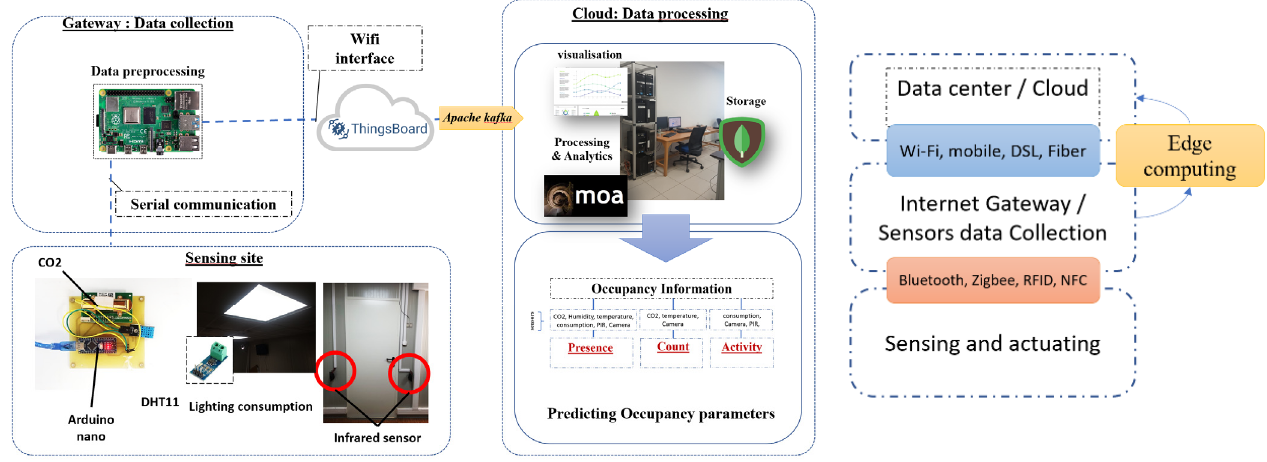
Figure 2. The proposed platform architecture